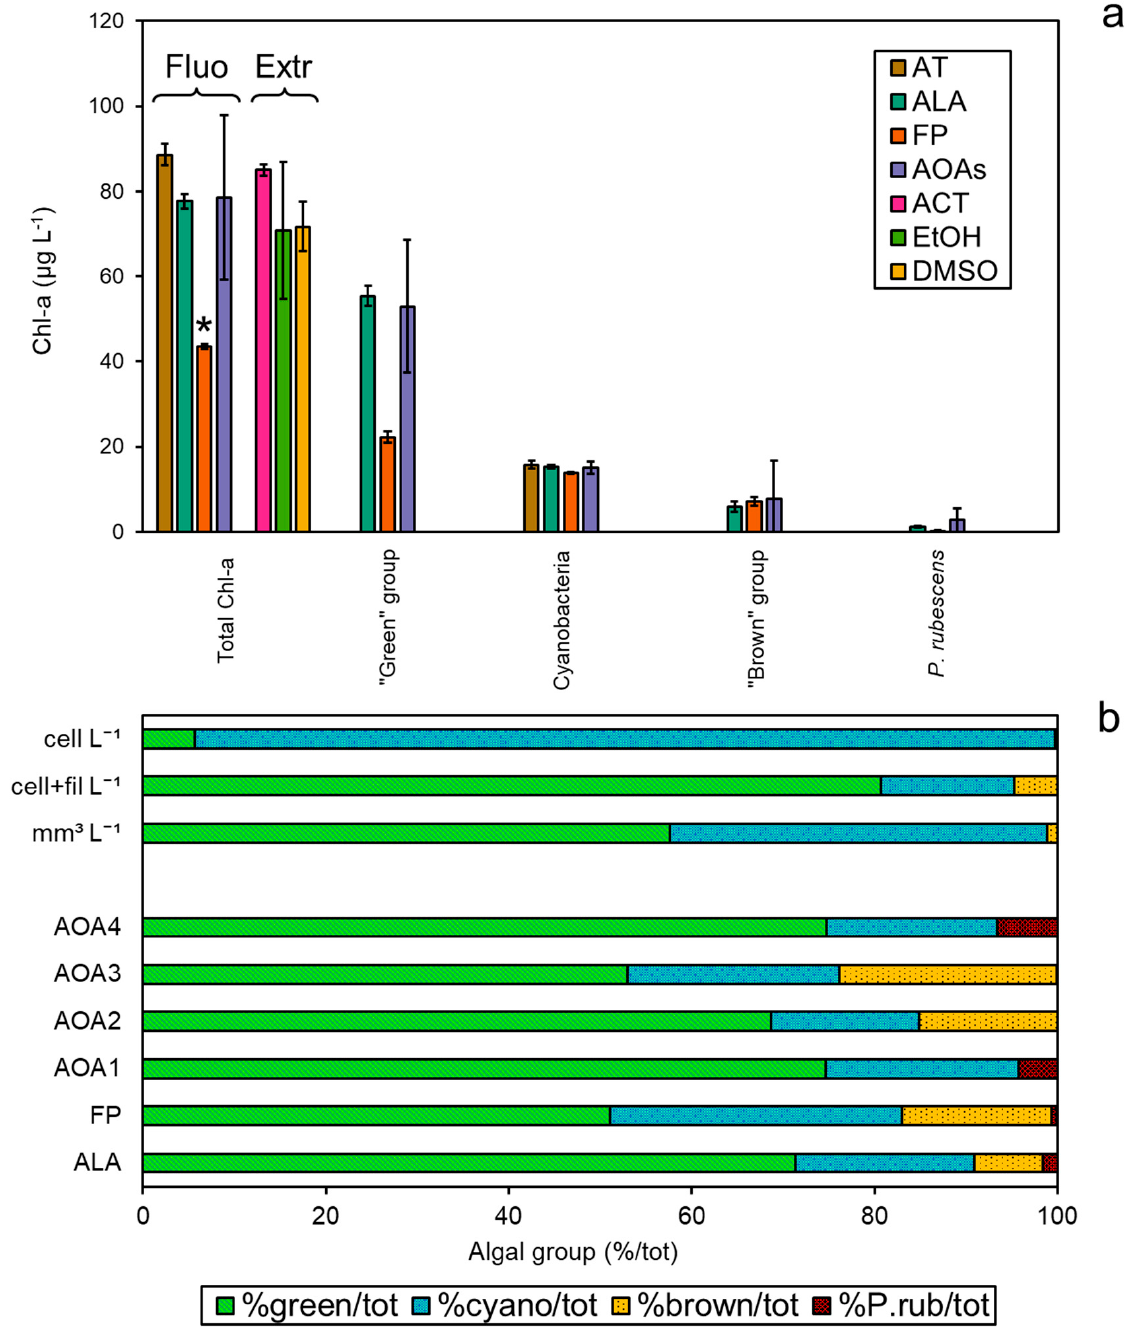
Figure 4. Application of the probes to a field sample collected from Reno River (Emilia-Romagna, Italy). ( a ) Total Chl -a concentrations ( μ g L − 1 ) based on spectrofluorometers and extraction determinations per algal group, i.e., “green” group, Cyanobacteria, “brown” group, and P. rubescens . ( b ) Relative distribution of the algal groups observed per means of different methods expressed as percentage of the total, from the top to the bottom: biovolume (mm 3 L − 1 ), number of cells per liter (cell L − 1 ), cells and filaments per liter (cell+fil L − 1 ), and percentage of algal group attribution by the probes. * Significant comparisons for total Chl -a (ANOVA, p < 0.05).